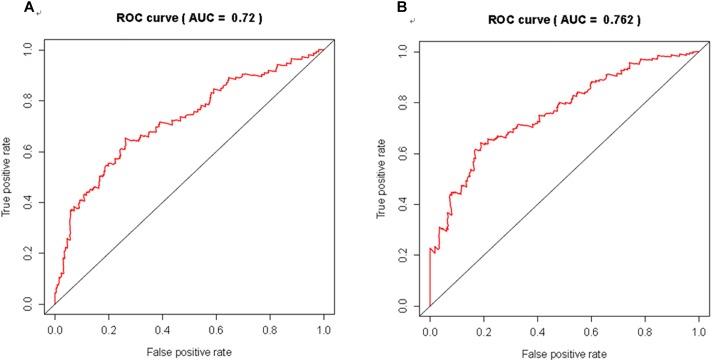
The discriminatory ability of the evaluated multivariate DEGs in melanoma was accessed with ROC curve. (A) for 3 year; (B) for 5 years.